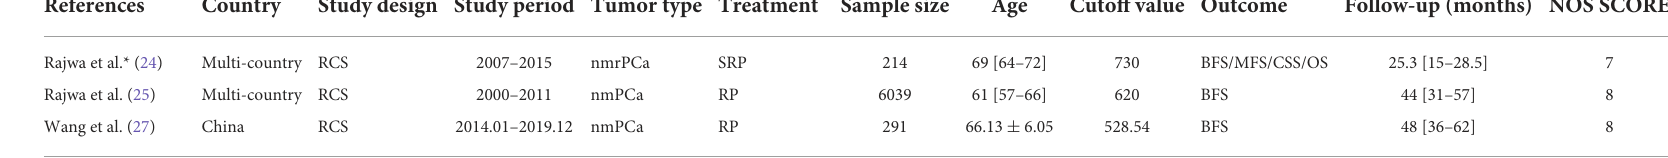
TABLE 2 Baseline characteristics of included nmPCa